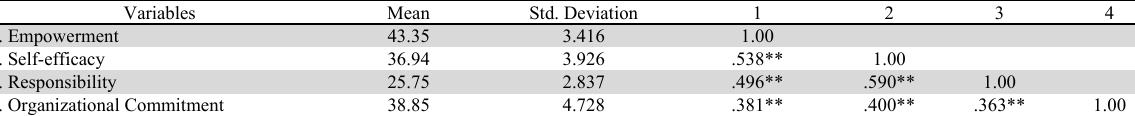
Descriptive Statistics and Correlation Matrix of Variables